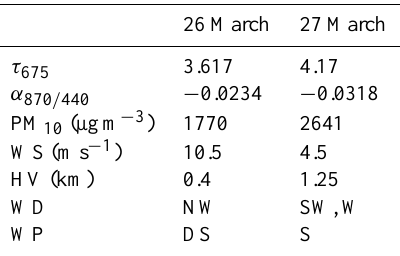
Table 1. The dust storm’s optical and physical properties together with the average PM 10 and the corresponding meteorological pa- rameters at 11:30LT ( +